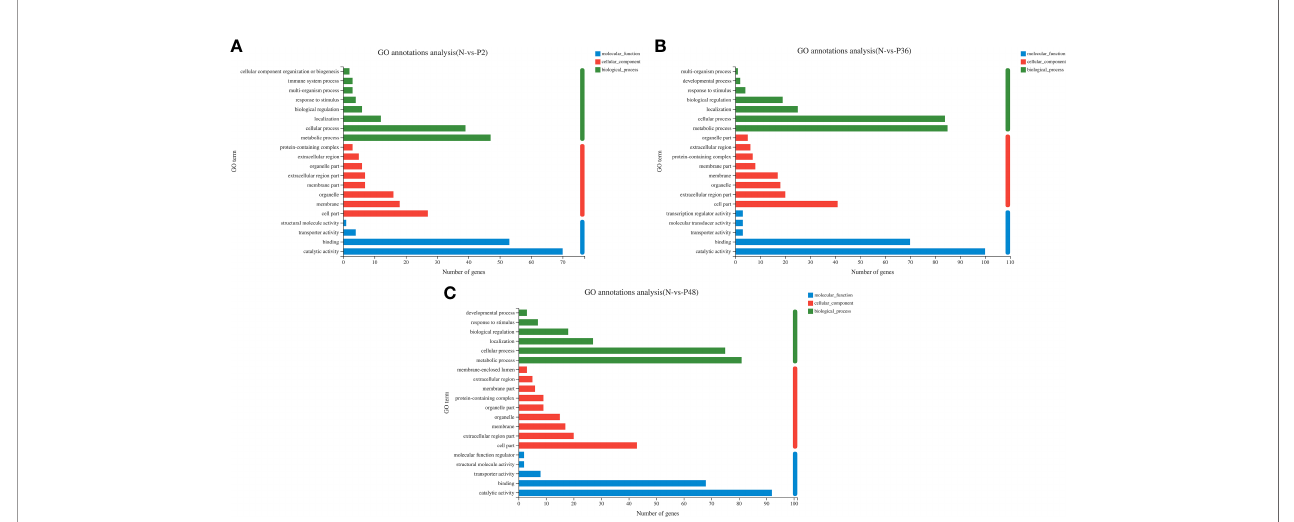
FIGURE 2 | Gene ontology (GO) annotation analysis of DEGs in pairwise comparisons between the control (N) and different time points after challenge (P2, P36 and P48). (A) N vs P2. (B) N vs P36. (C) N vs P48.